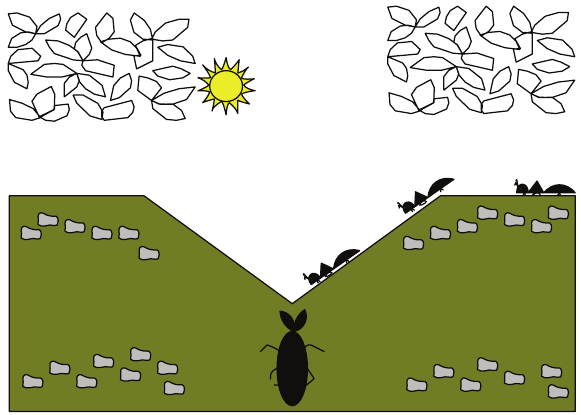
Figure 2: The hunting behavior of